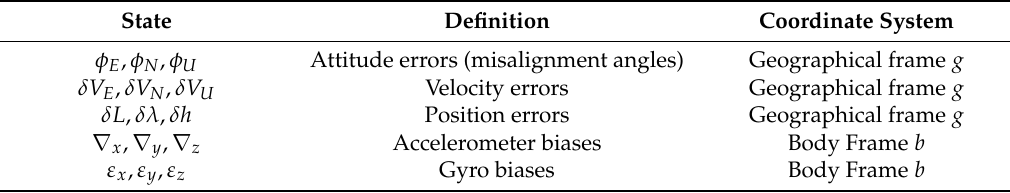
Table 1. The state vector with 15